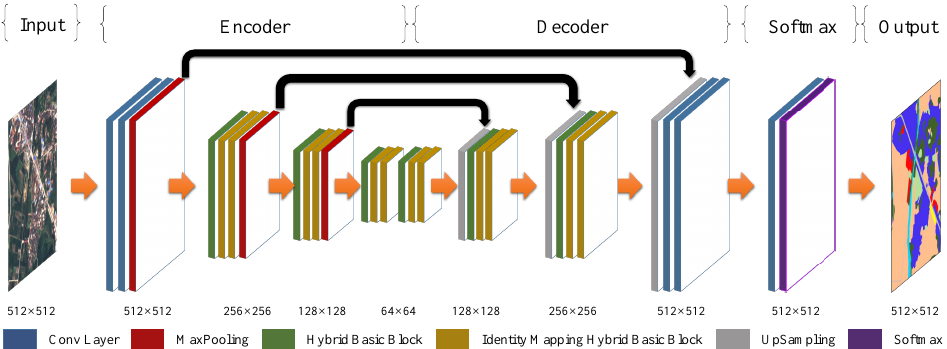
Figure 3. The backbone structure of SDFCN v2 model. The black arrow in the figure indicates a shortcut